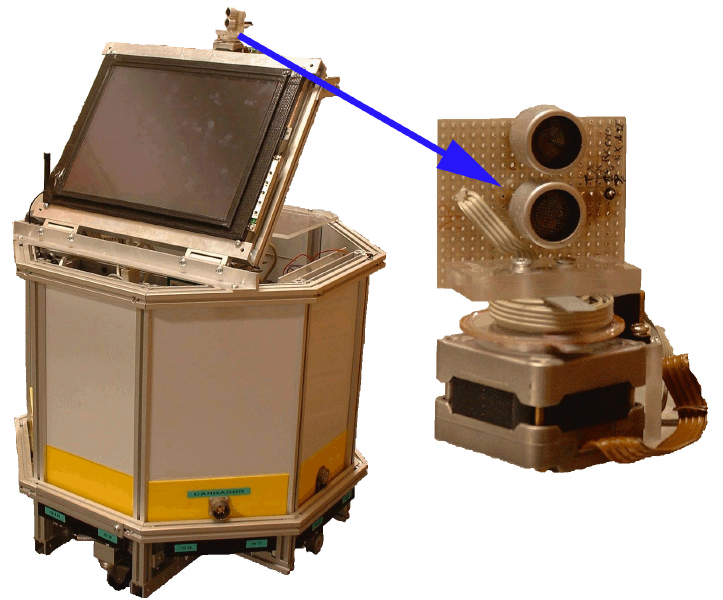
Figure 1. YAIR robot prototype. The sonar sensor can be seen in more detail at the right part of the figure. The transmitter and the receiver are piezo-ceramic transducers vertically aligned and driven by a stepper motor.